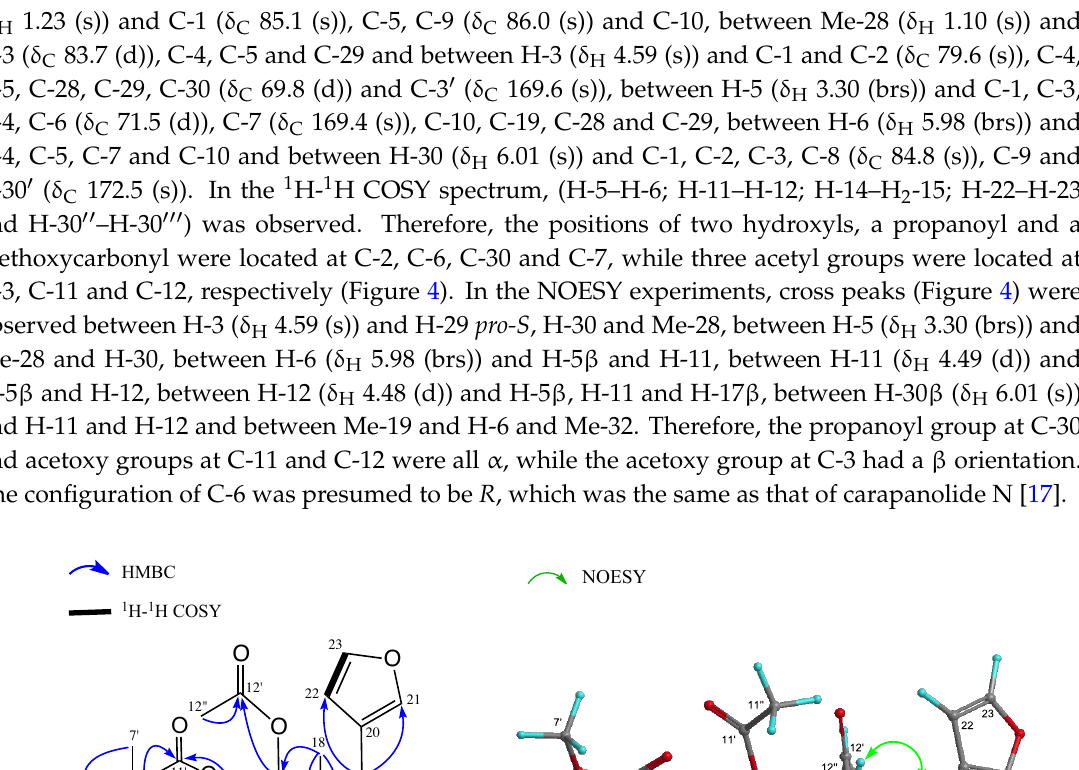
Figure 4. Key HMBC, COSY, and NOESY correlations for Carapanolide X ( 5 ).